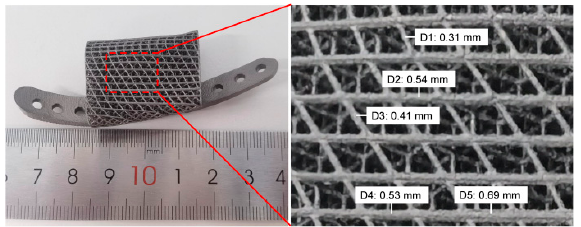
Figure 11. The printing details of the optimized prosthesis and the theoretical diameter (D1–D5) of part struts.